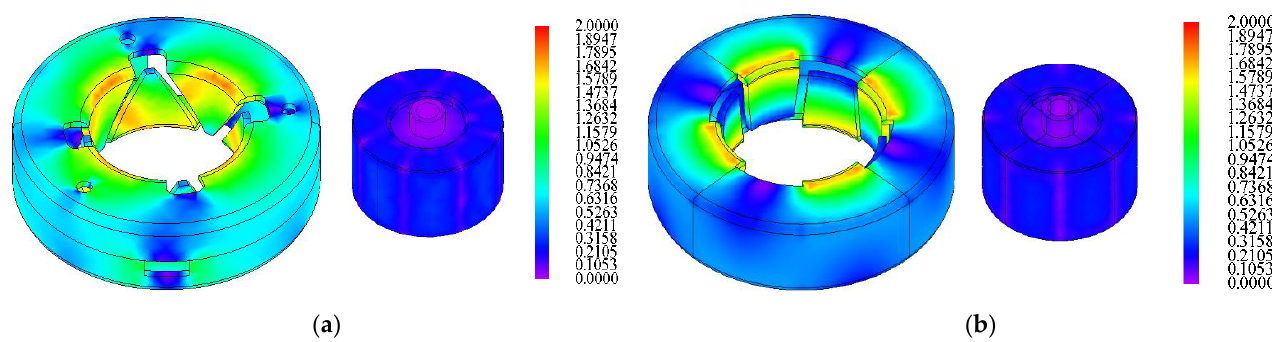
Figure 19. Magnetic flux densities of the base and proposed models in the load condition (left side, stator, rotor, and legend are shown): ( a ) base model; ( b ) proposed model.